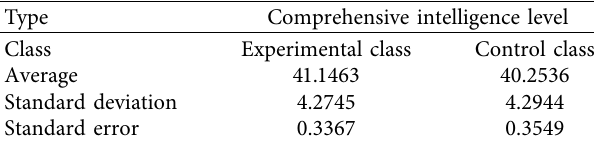
Table 1: Statistics of the number of people in the experimental class and the control class.